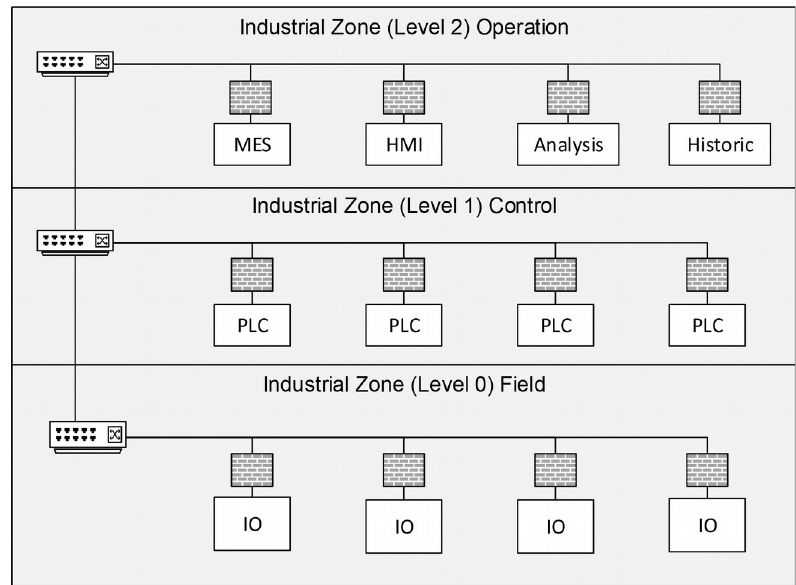
Figure 4. Secure manufacturing system architecture with SDN